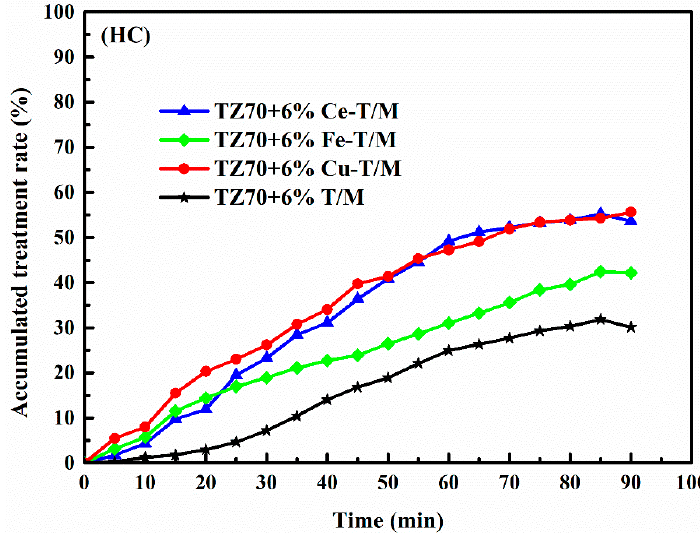
Figure 8. Degradation curve of HC by four modified bitumen.